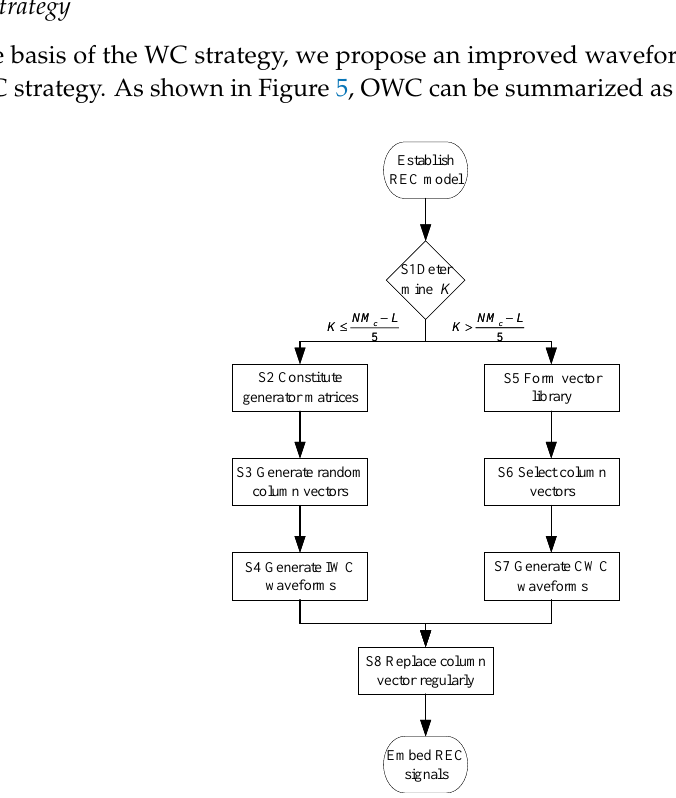
Figure 5. Flow chart of orthogonal weighted-combining